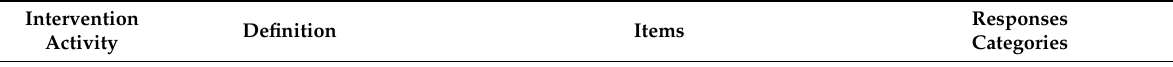
Table 3. Intervention activity variables—student level and staff/manager